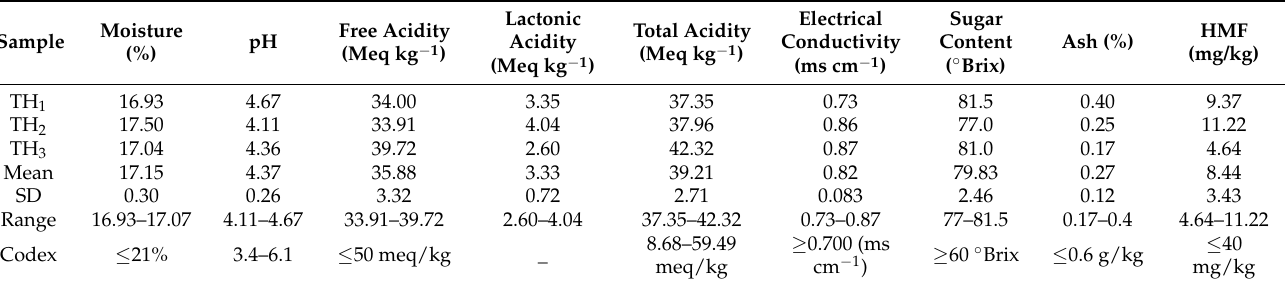
Table 5. Physicochemical parameters of Thymus vulgaris